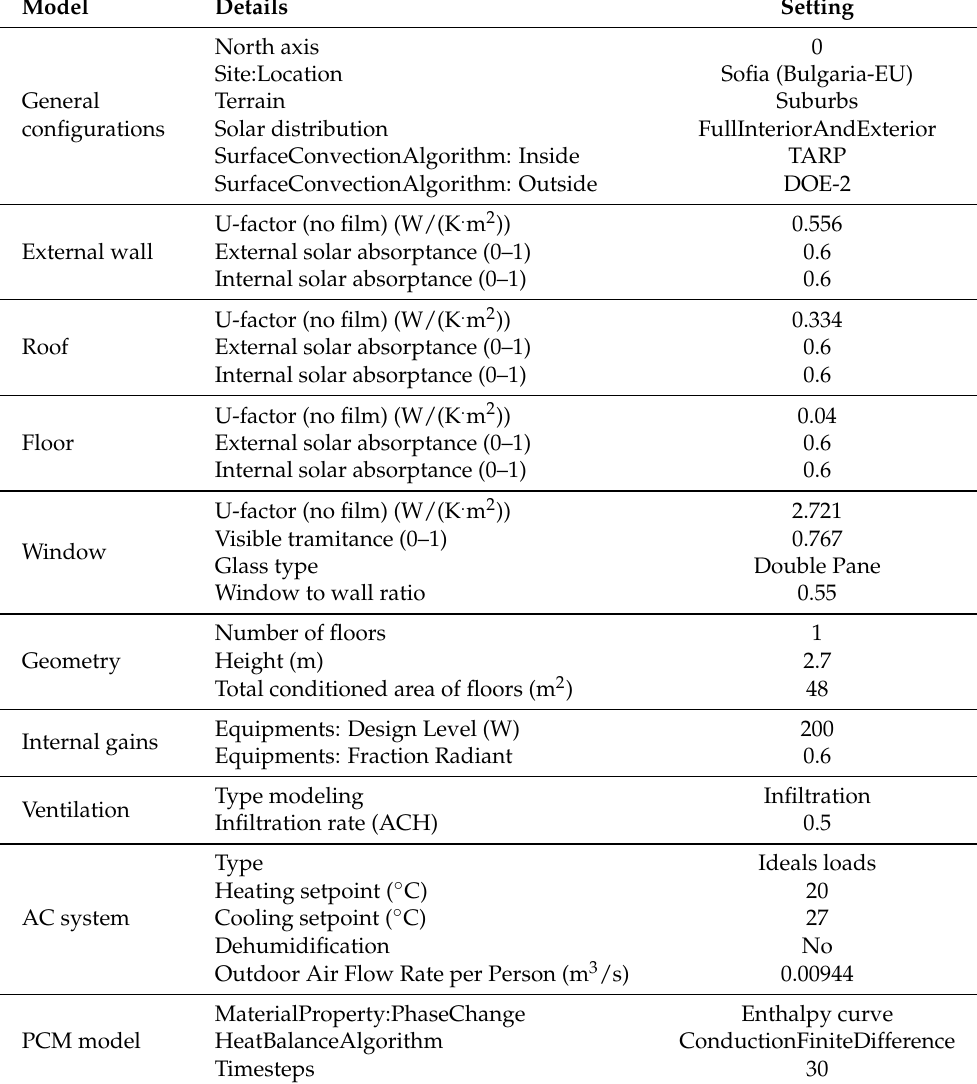
Table 3. Details of the building model configuration used in EnergyPlus for the BESTEST